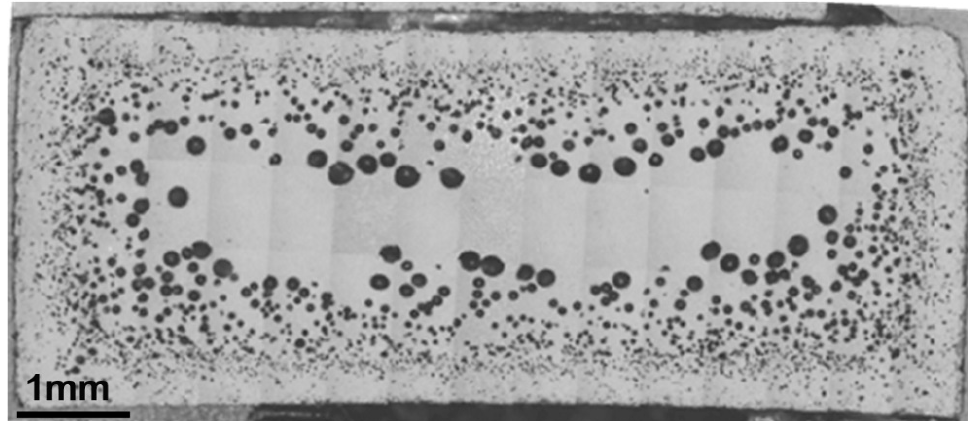
Figure 11. Porosity annular distribution in R10.